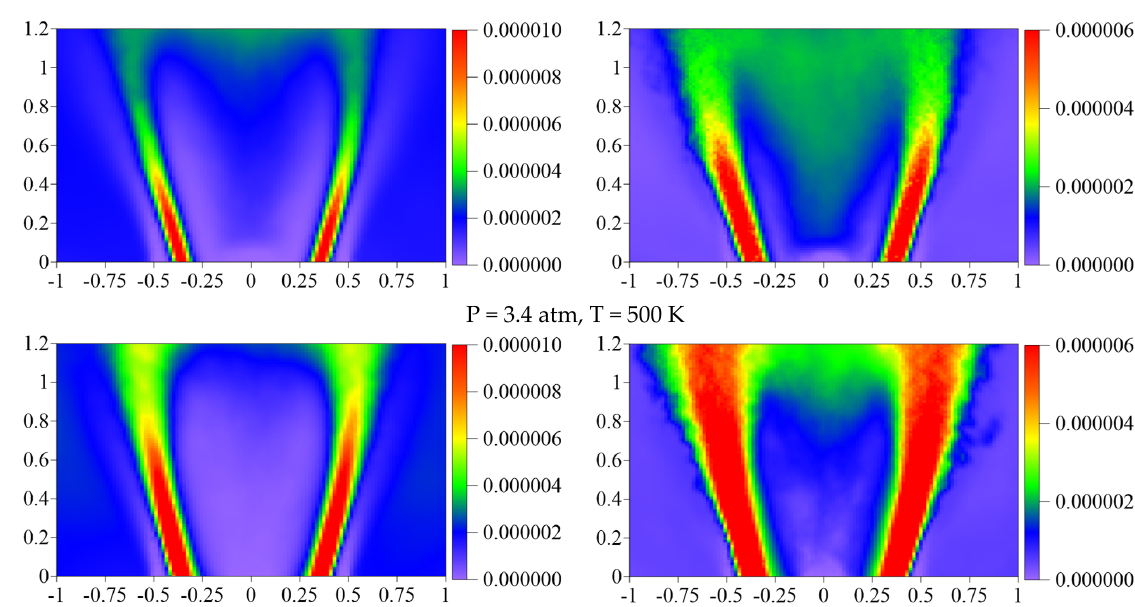
Figure 10. Mean NO 2 concentration fields and RMS of the concentration fluctuations evaluated by the LES approach.